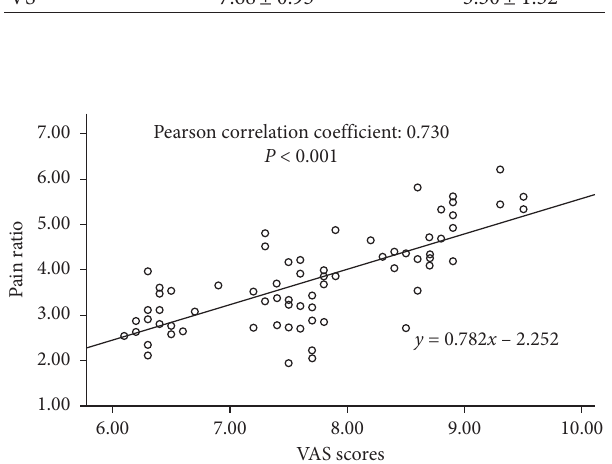
Figure 1: Pain vision system measured pain ratio before treatment was linearly correlated with patient VAS score.